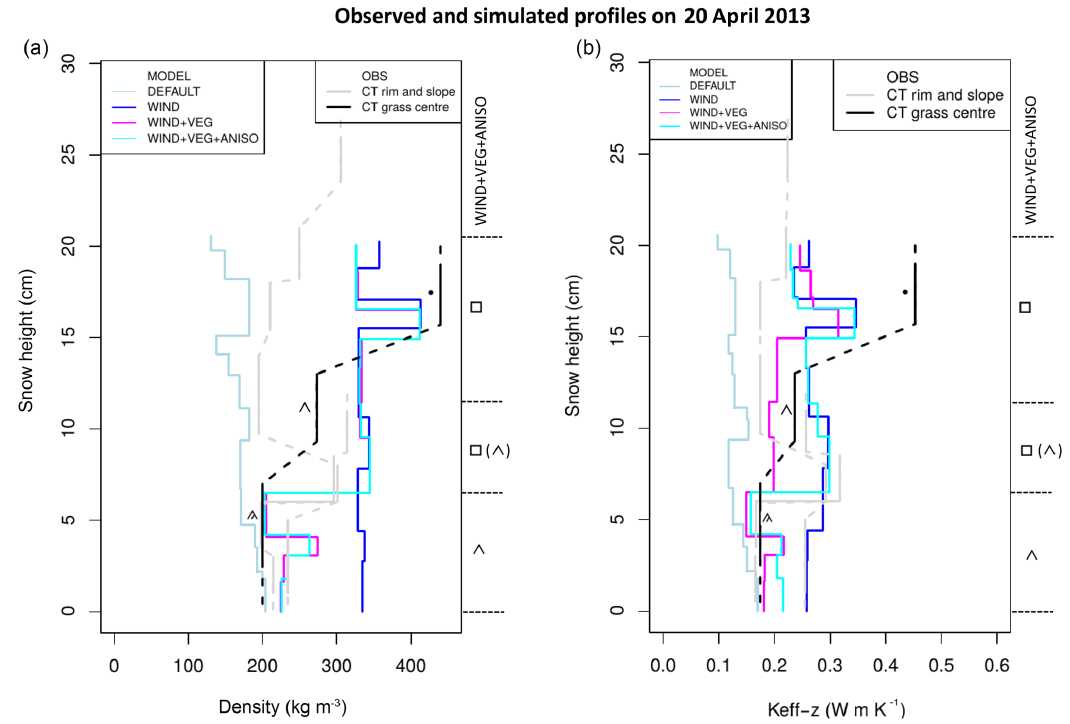
Figure 7. Observed and simulated density and K eff − z profiles on 20 April 2013. Observations (OBS) are the estimates made using the CT method at the three CT sites with basal vegetation; grain shape is indicated on the plot for the CT grass-centre site. Simulations (MODEL) were made with the four SNOWPACK set-ups; grain shape is indicated at the side for the WIND + VEG + ANISO